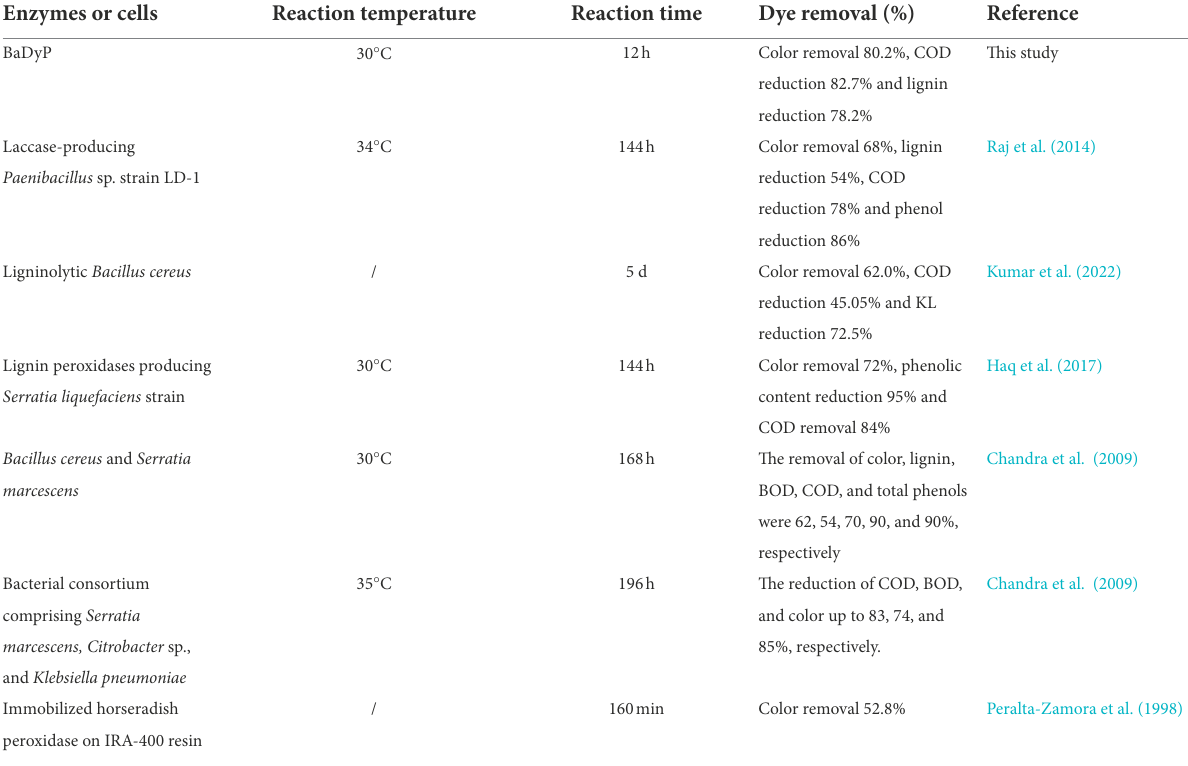
TABLE 3 Comparison of BaDyP and other biological approaches for the treatment of pulp and paper wastewater. Enzymes or